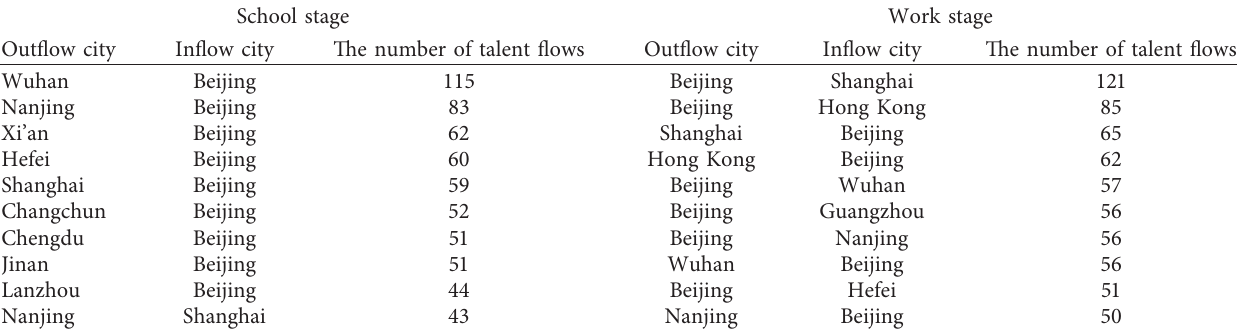
Figure 2: Hierarchical structure diagram of the talent mobility Table 1: Top 10 city pairs of the number of talent flows.